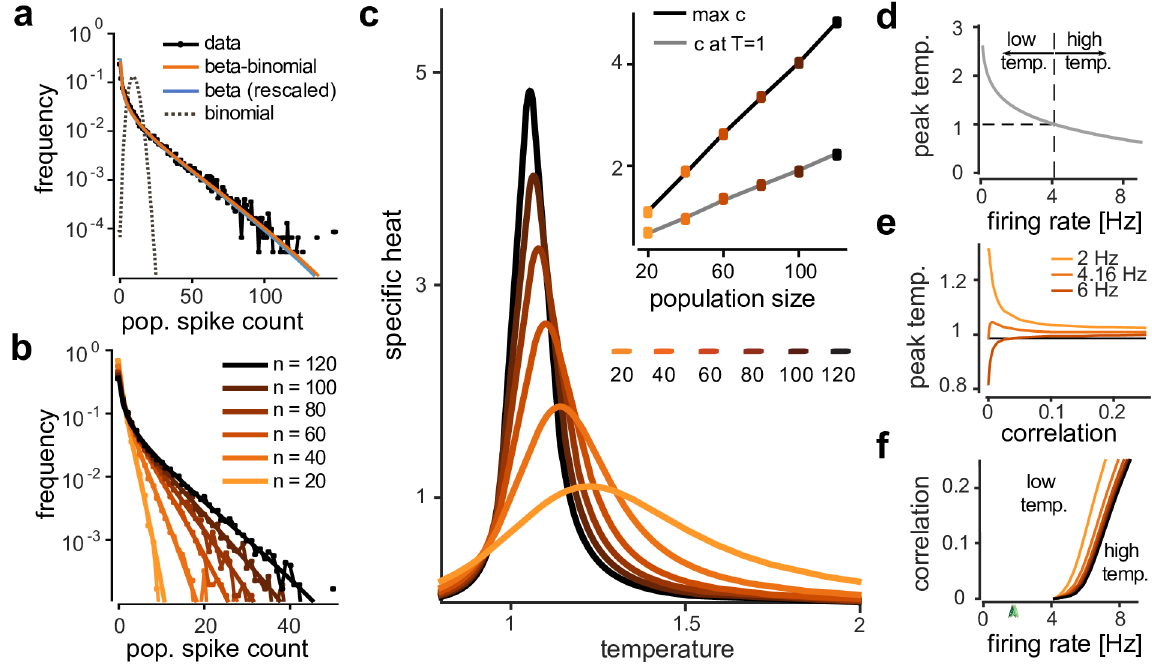
Fig 3. Signatures of criticality and low-temperature states in a mathematically tractable model. a) Population spike-count distributionin RGC simulation, and approximation by models. Only the beta-binomial populationmodel fits simulateddata accurately, and for the full recording( N = 316) closely matches the shape of a beta distribution. b) Beta-binomialmodel fits for different population sizes. c) Specific heat traces for beta-binomialmodel, exhibitingsignatures of criticality. Average and individualtraces for 30 randomlysampledpopulationsfor each of 6 different population sizes. Inset: Specific heat at unit temperature and at peak vs. populationsize. d) Locationof peak specific heat for independentmodel as function of firing rate. For μ / Δ = 4.16Hz (assuming Δ = 20ms bins), the peak is aboveunit temperature, a ‘low-temperature phase’. d) Locationof peak specific heat as function of correlation, for n = 100 and three different firing rates. Peaks cross T = 1 only for firing rates (cid:21) 4.16Hz. e) ‘Low’ and ‘high’temperature phases for beta-binomial model as function of firing rate and correlationstrength and for populationsizes ( n = 20 to n = 120, colors as in b , c ). Increasingcorrelationsand population size expandthe low-temperature regimebeyond 4.16Hz. Data sets from previous studies had averagefiring rates well within low-temperature regime (arrows, colors as in Fig. E in S1 SupportingInformation).